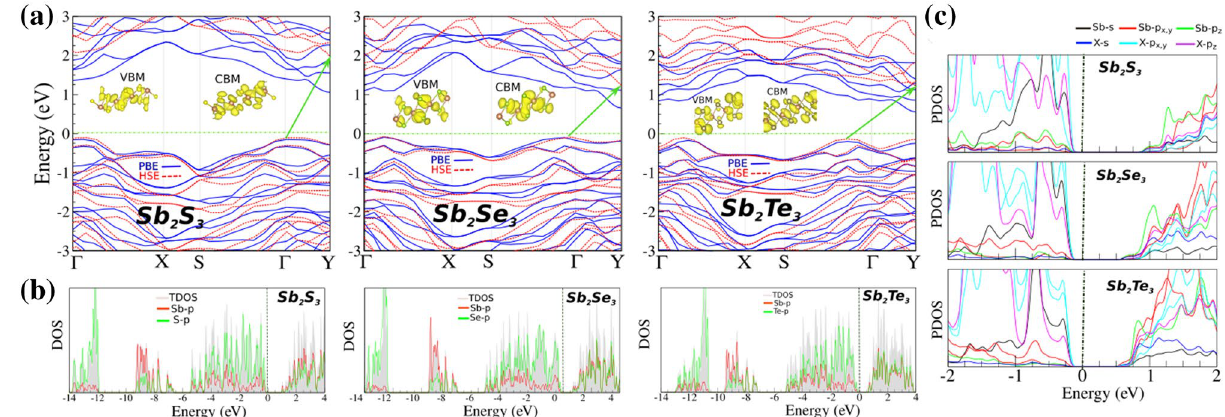
Figure 3. ( a ) Electronic band structure, ( b ) density of states (DOS) and ( c ) projected DOS (PDOS) of Sb 2 X 3 monolayers. The zero of energy is set to